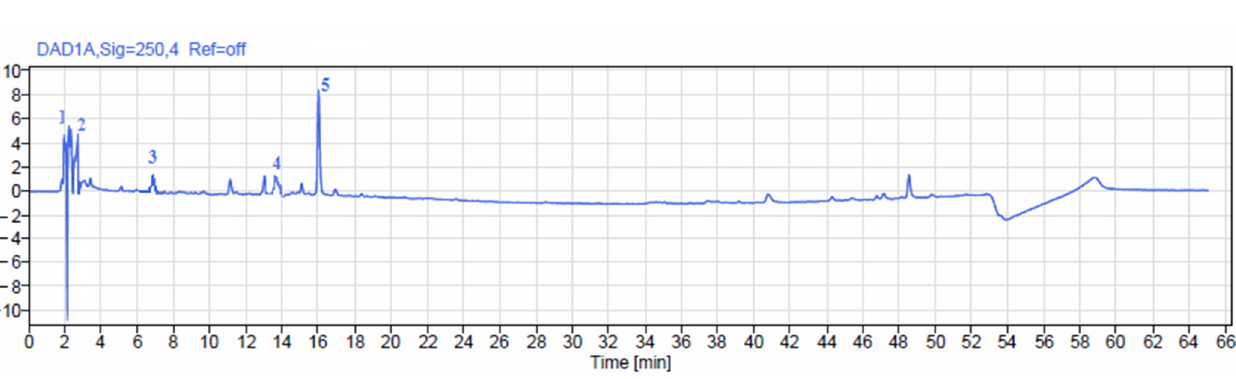
Figure 3. Chromatographic profile of phenolic compounds identified in polyphenol extract of A. europaea . Table 1. Phenolic compounds identified using HPLC in a polyphenol extract of A. europaea.